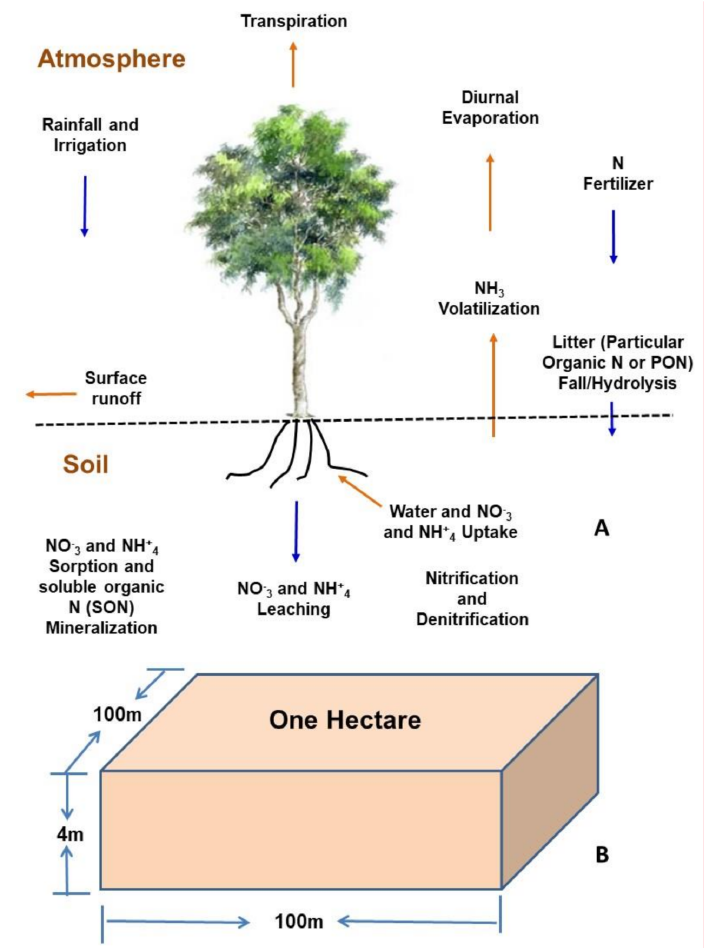
Figure 1. Schematic diagram showing the water and N dynamics in a growing-eucalyptus plantation ( A ) with the modeled domain used in this study ( B ). The diagram is modified from Ouyang et al. [27]. Leaf water transpiration depends on daily weather conditions, age of tree